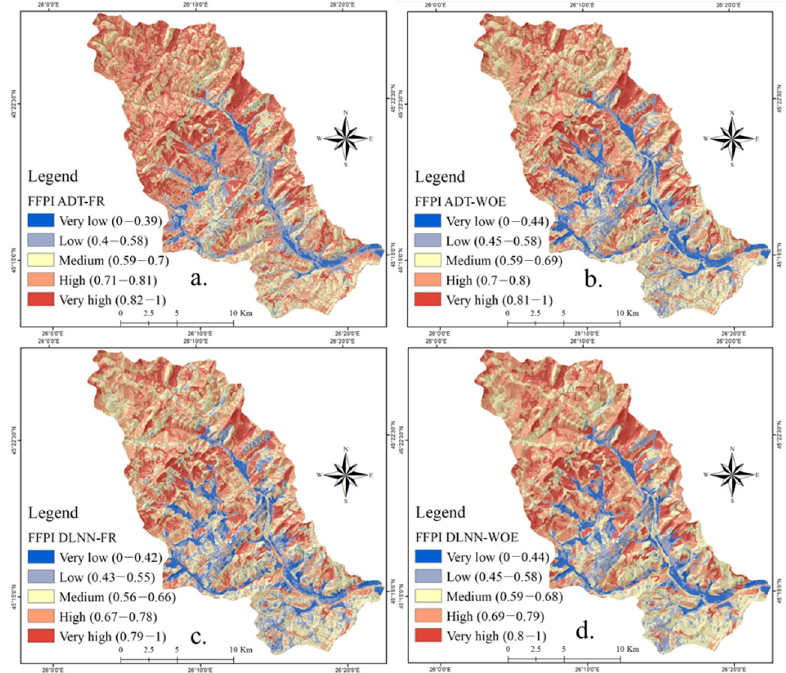
Figure 9. Flash-flood predictors importance.